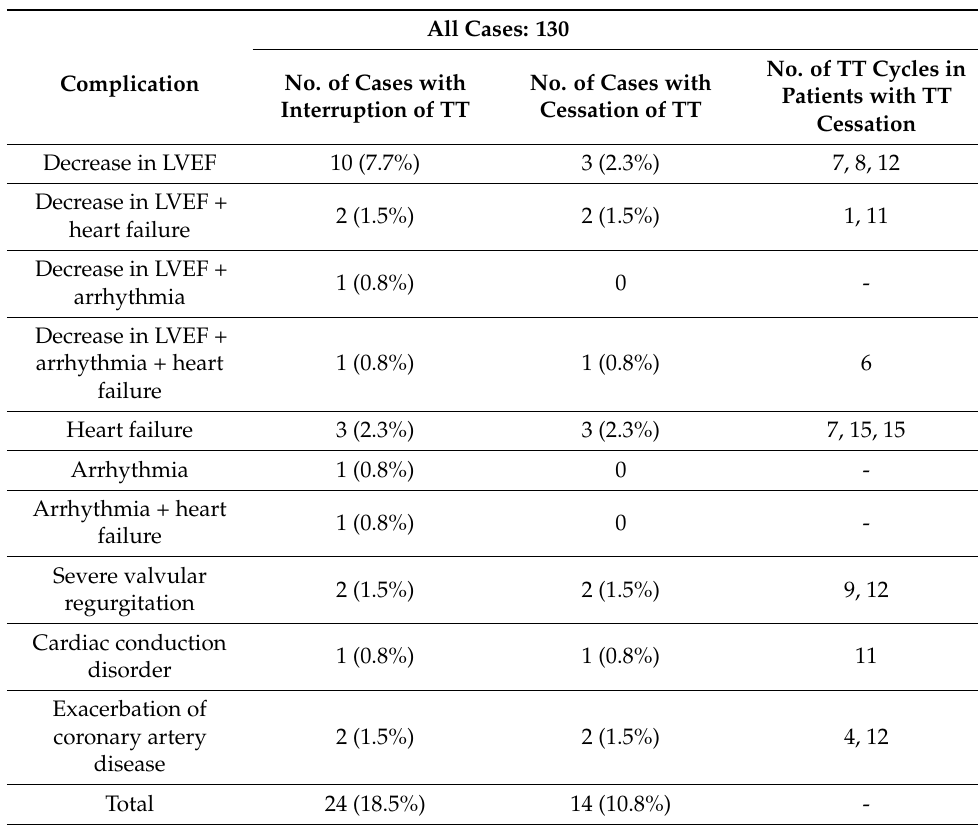
Table 2. Cardiac complications during trastuzumab